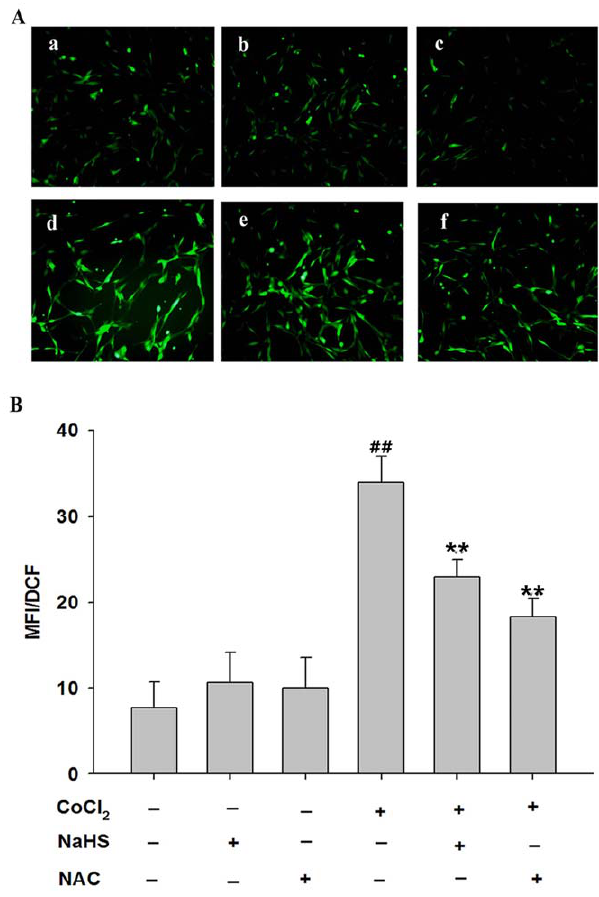
Figure 3. Effects of NaHS and NAC on CoCl 2 -induced overpro- duction of reactive oxygen species (ROS) in PC12 cells. (A) Random micrographs of dichlorofluorescein (DCF)-derived fluorescence in PC12 cells. A-a: Control, untreated cells; A-b: NaHS group, cells were treated with 400 m mol/L NaHS for 30 min alone; A-c: NAC group, cells were treated with 500 m mol/L NAC for 60 min alone; A-d: CoCl 2 -treated group, CoCl 2 cells treated with 600 m mol/L CoCl 2 for 6 h; A-e: NaHS + CoCl 2 group, cells were preconditioned with 400 m mol/L NaHS for 30min prior to treatment with 600 m mol/L CoCl 2 for 6 h; A-f: NAC + CoCl 2 group, cells were preconditioned with 500 m mol/L NAC for 60 min prior to treatment with 600 m mol/L CoCl 2 for 6 h; (B) Quantitative analysis of the mean fluorescence intensity in the indicated groups. Data are the mean 6 SE (n=3). ## P , 0.01 compared with control, ** P , 0.01 compared with CoCl 2 -treated